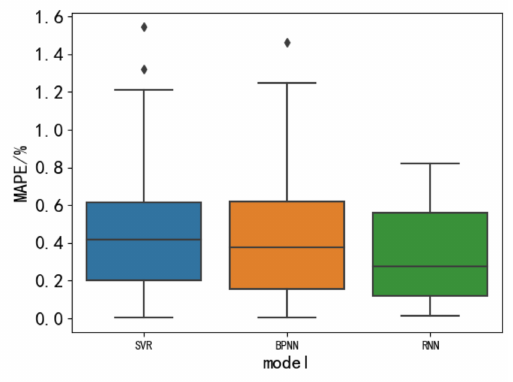
Figure 12. MAPE box and whisker plots of the predictions of different methods.